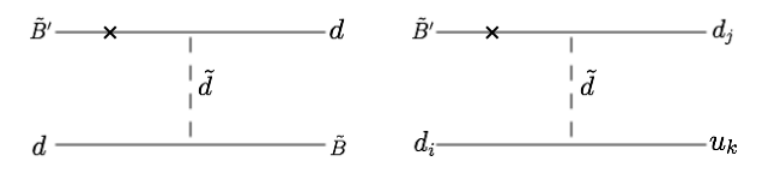
Figure 2 . Leading ~ B 0 interactions that determine its freeze-out in the minimal scenario. The crosses represent the (cid:15) mixing angle between the ~ B 0 and the ~ B